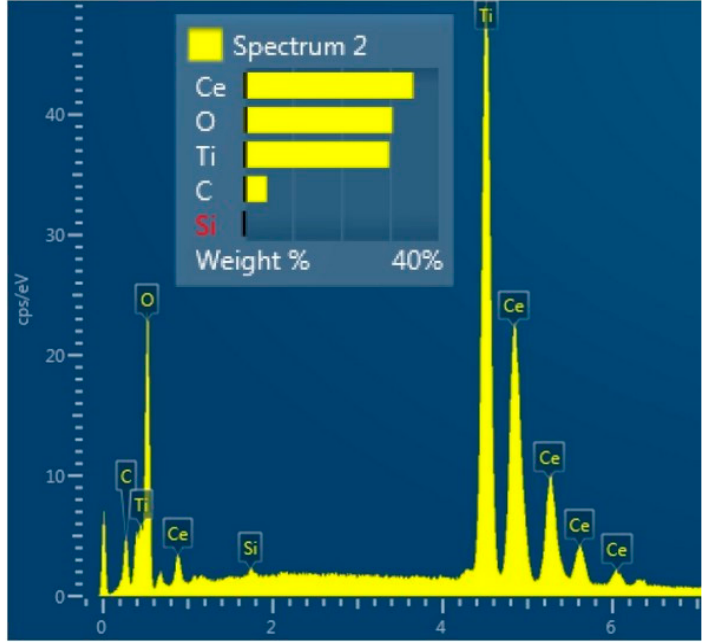
Figure 8. The EDS analysis of the TiCe-0.5:0.5-40 sample.